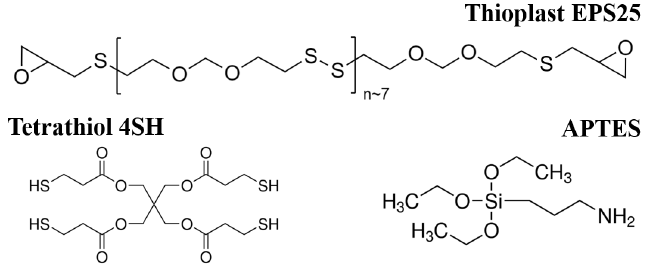
Figure 2. Semi-developed formulas of the epoxy monomer (Thioplast EPS25) and the crosslinkers (4SH and APTES).